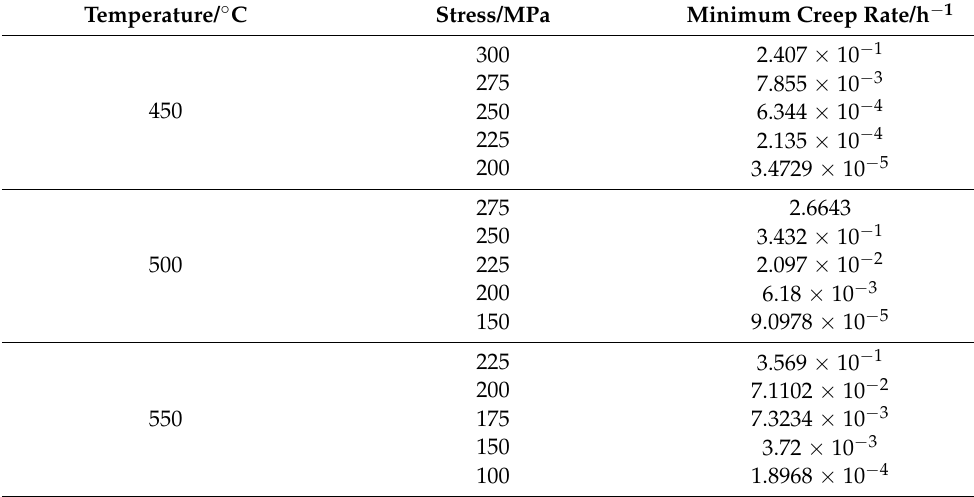
Table 3. Minimum creep rate under various test